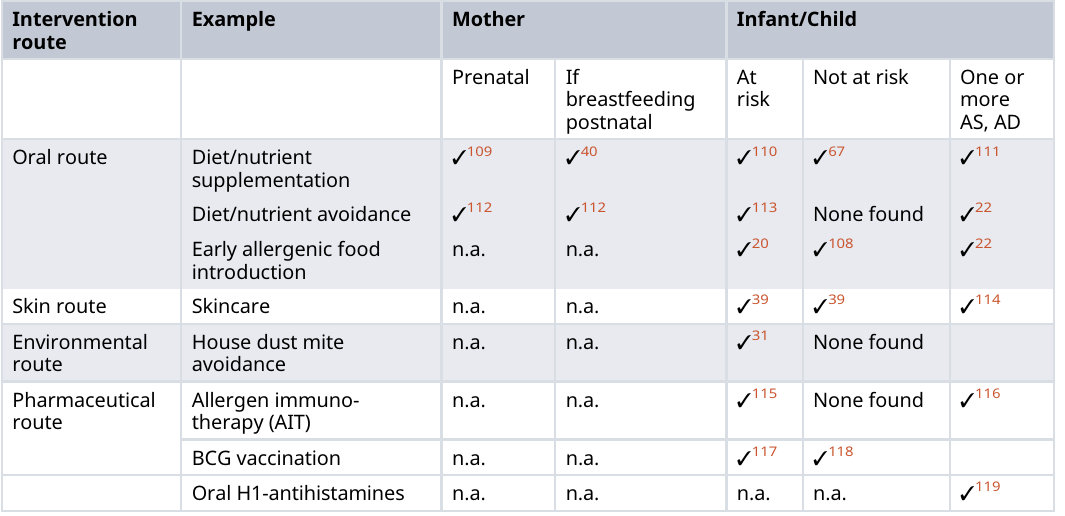
Table 1. Overview of primary ECAP strategies investigated thus far or in progress in RCTs Intervention